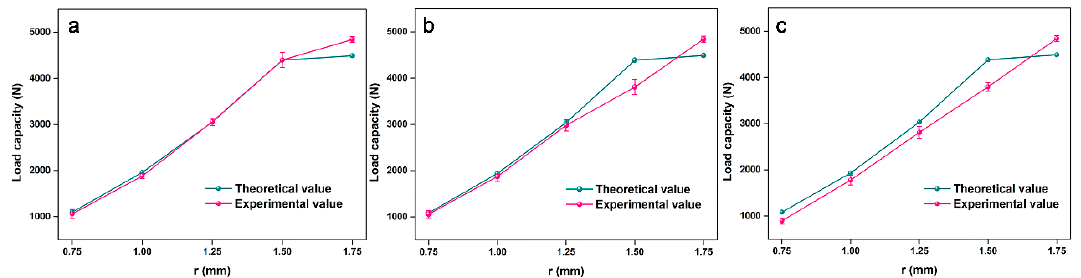
Figure 8. Flatwise compressive load capacity of (a) n = 1, (b) n = 2, and (c) n = 3.